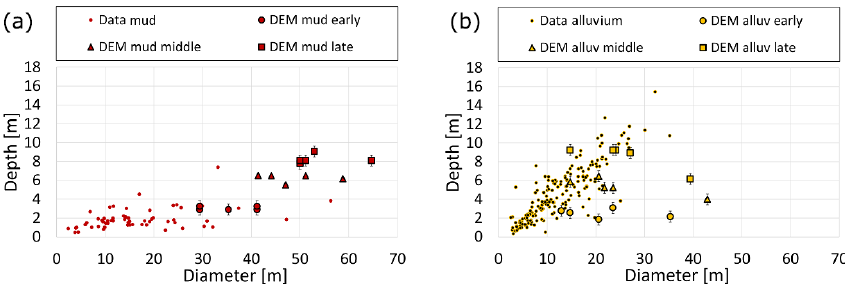
Figure 15. Sinkhole depth / diameter ratios from photogrammetry (Al-Halbouni et al., 2017) and DEM model results of this study. For field data, depth and diameter for the materials alluvium and mud were determined for 237 sinkholes. The mean values are 0 . 4 ± 0 . 11 for sinkholes in alluvium and 0 . 14 ± 0 . 04 for those in mud. No field data were available for salt at the time of this study. For the models, we distinguish between early collapses (circles), middle collapses (triangles) and late collapses (squares); (a) mud-flat sediments and lacustrine mud models, (b) alluvial sediments and multilayer alluvium on lacustrine mud model